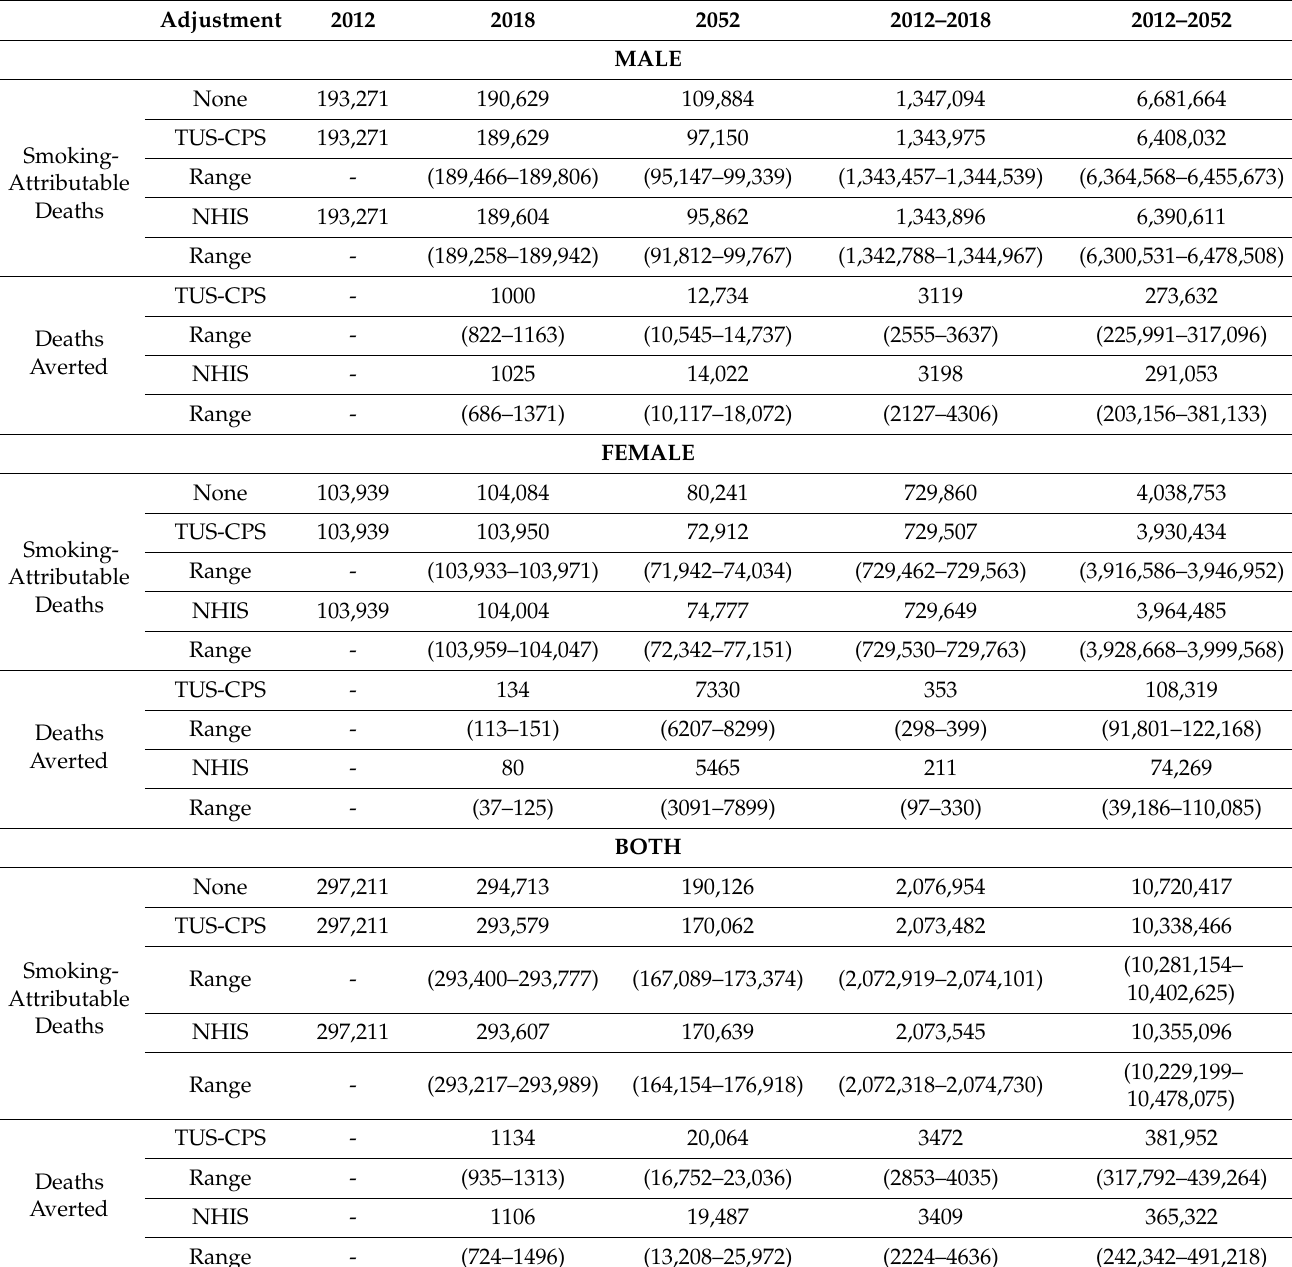
Table 5. Projected smoking-attributable deaths and lives saved, unadjusted US SimSmoke compared to TUS-CPS NVP- adjusted and NHIS NVP-adjusted US SimSmoke (for ages before 45), by gender,